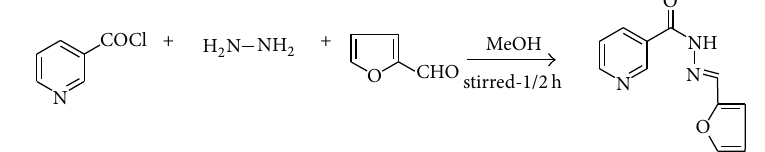
S 2: Route for the synthesis of the 2-furyl-(pyridine-2-carbo)-iminohydrazone Ligand.